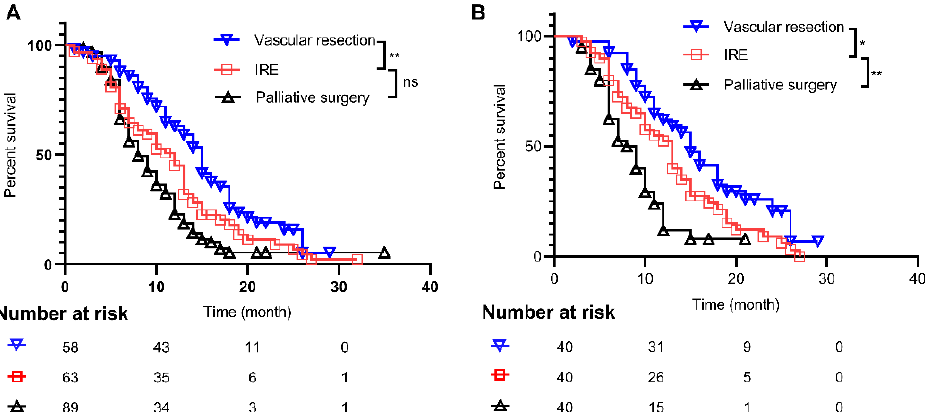
Figure 1. Kaplan–Meier curves of overall survival for patients in different groups: ( A ) Comparison of overall survival among the three groups before matching; and ( B ) comparison of overall survival among the three groups after matching. *, p < 0.05; **, p < 0.01; ns, not significant; IRE, irreversible electroporation.